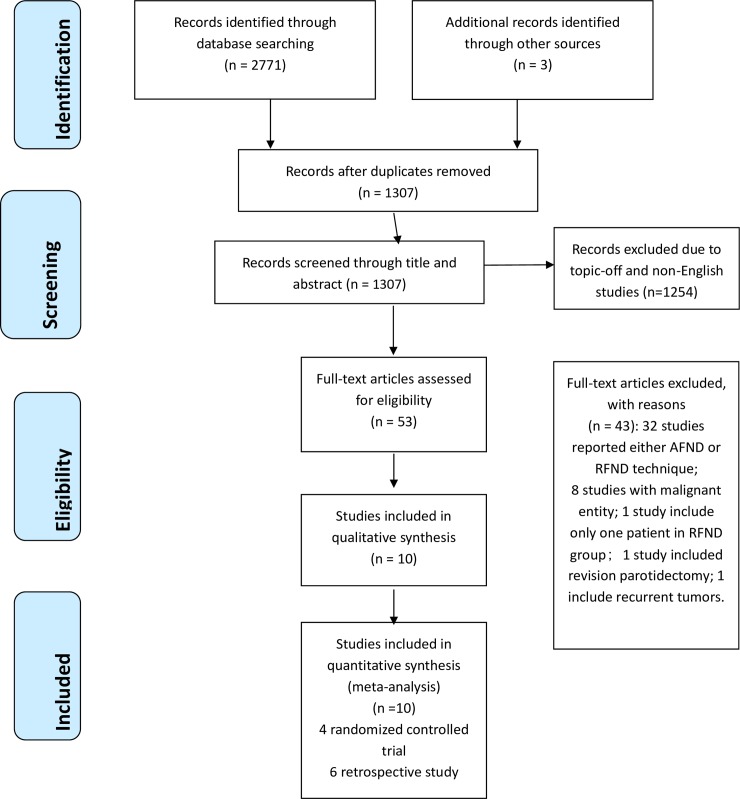
Study flow diagram.